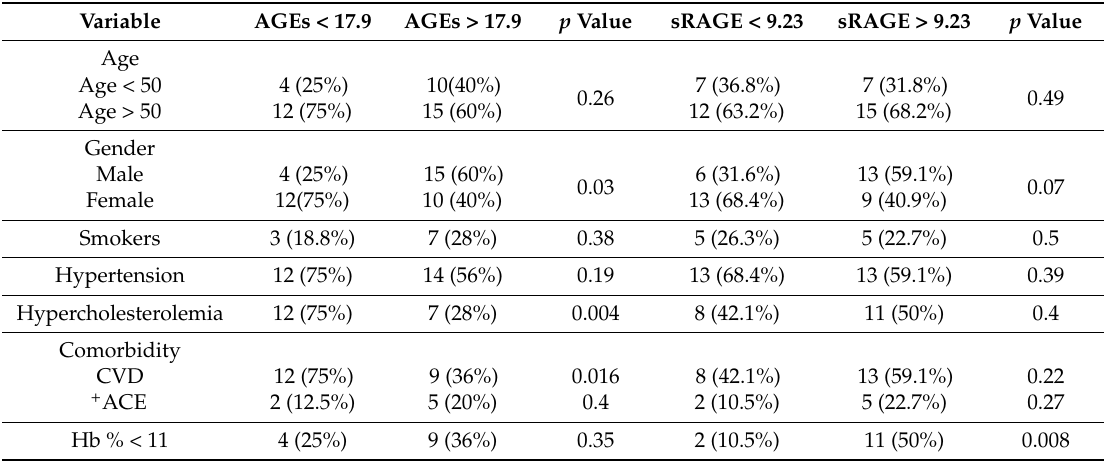
Table 5. Baseline characteristic of HD DM + patients according to AGEs and sRAGE (median level).